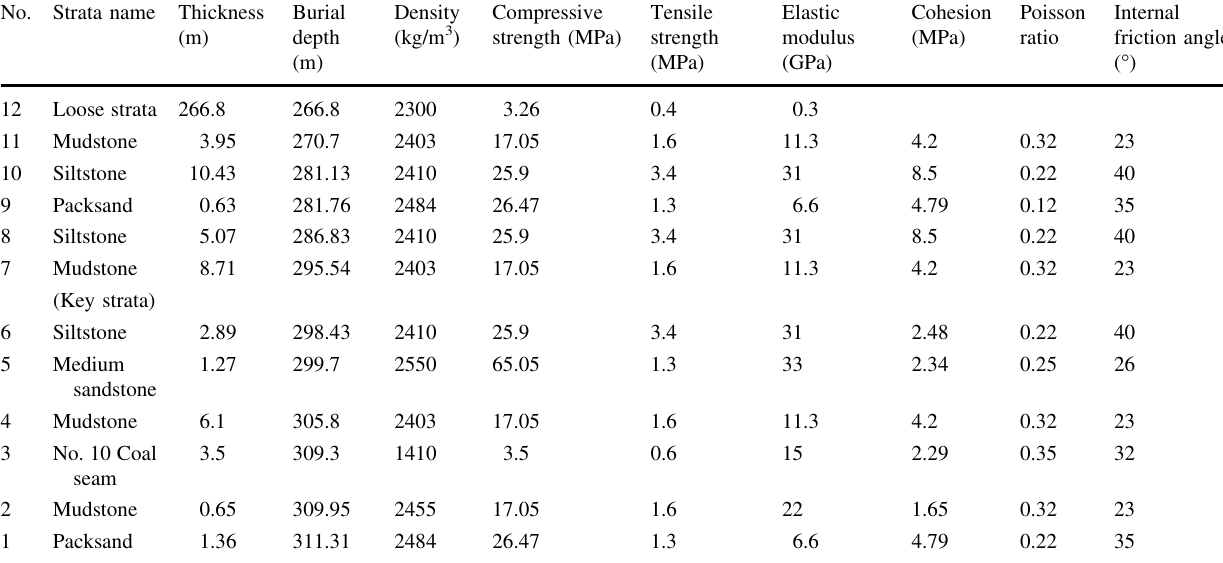
Table 1 Parameters of mining strata